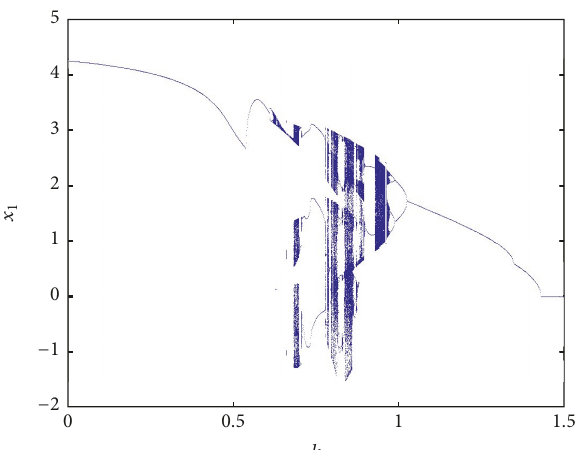
Figure 22: Bifurcation diagram of two coupled neurons for different memristor-type coupling intensities ( 𝑘 = 0 to 𝑘 = 1.5 ), while 𝐷 = 1 and other parameters are at their nominal values.